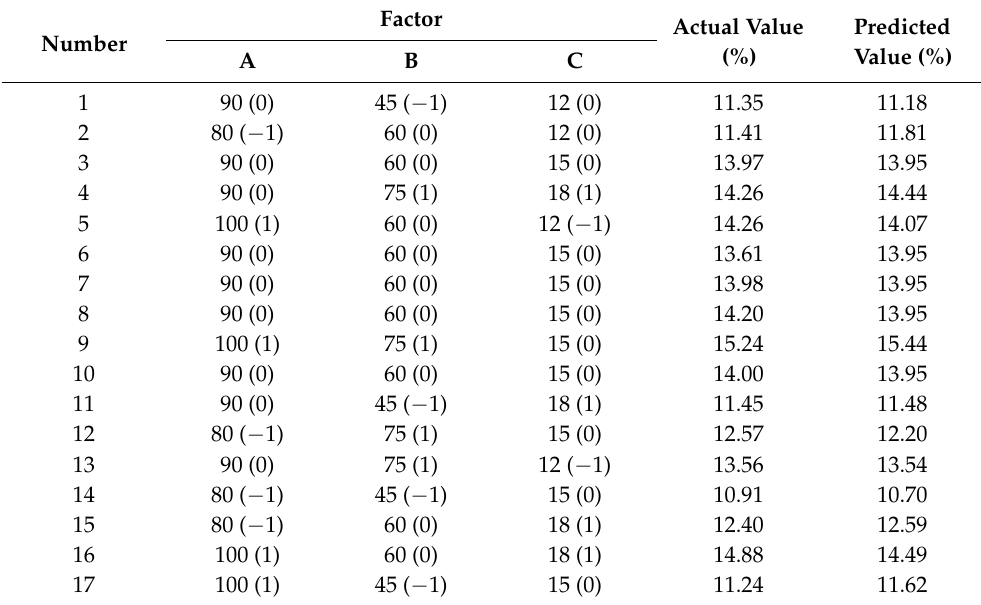
Table 1. Box–Behnken experimental design and results.